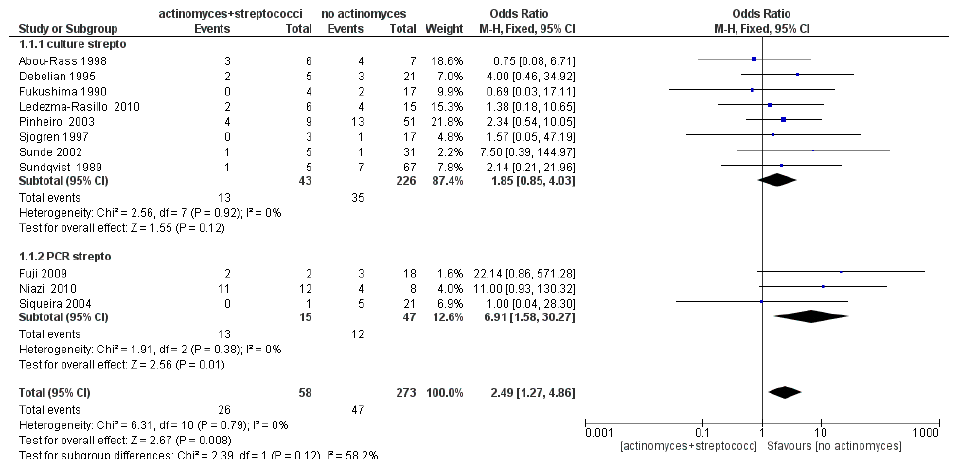
Figure 7. Forest plot of the fixed effects model of the meta-analysis of the sub-group Streptococci. Sub-group culture (OR = 1.85, 95% confidence interval (CI): [0.27, 4.03]), sub-group PCR (OR = 6.91, 95% CI: [1.58, 30.27]).